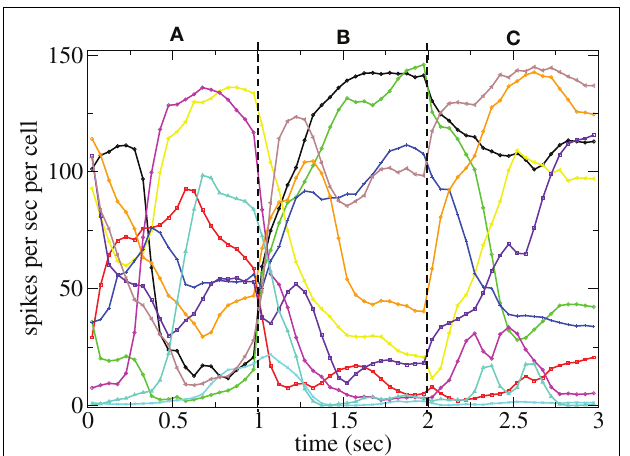
FIGURE 13 | Spike raster plot clustered by k-means algorithm with 15 clusters for 100 cell network simulations under input switching protocol 3 × 1s stimuli with high input strength ρ = 0.1, b C = 0.001, r C = 0.025, and α =